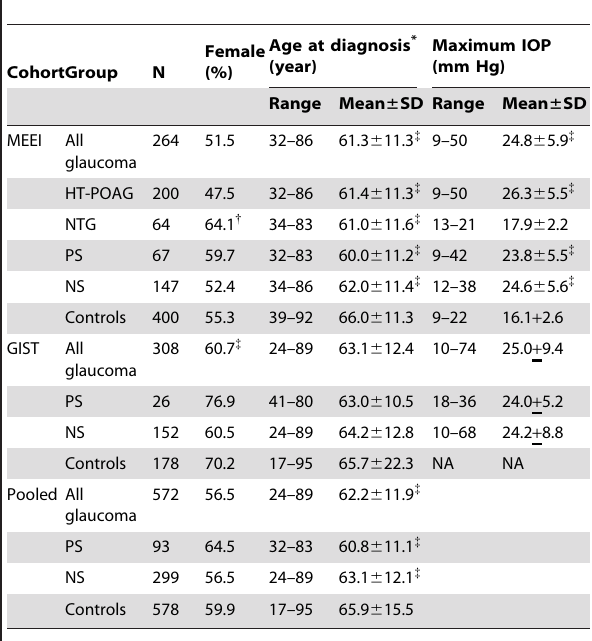
Table 1. Demographic features of the cases and